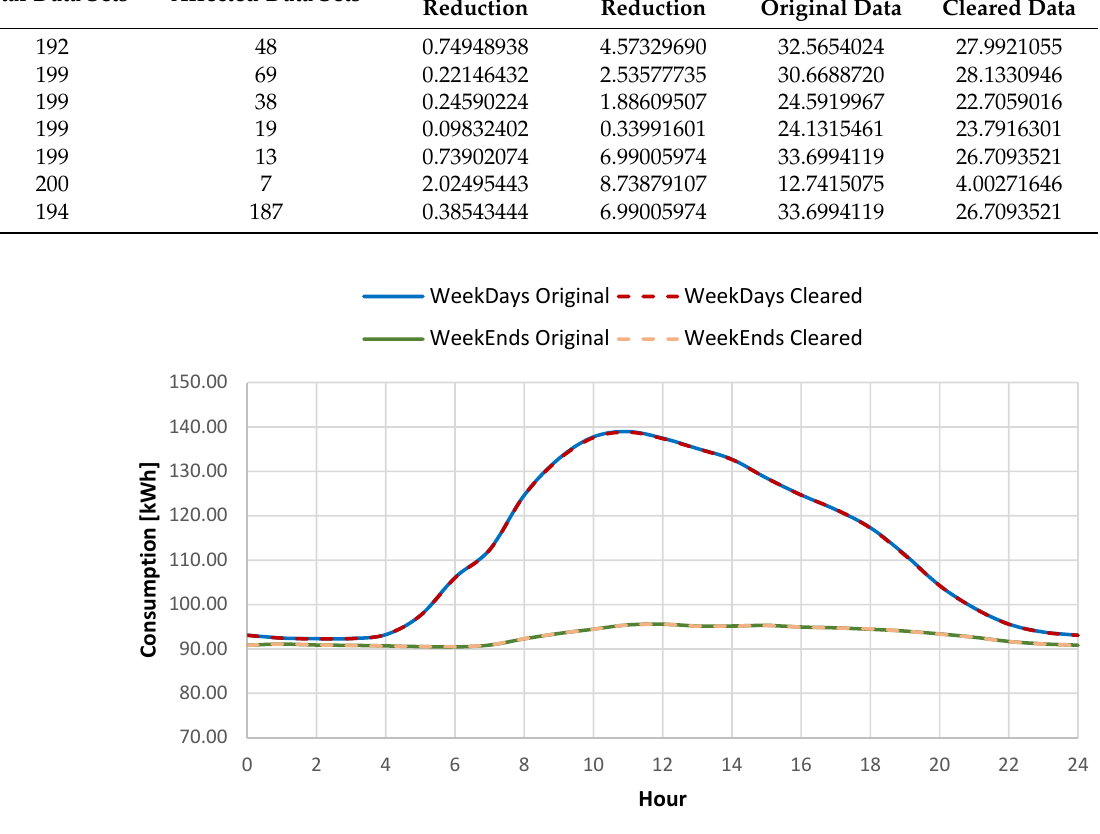
Figure 11. Daily consumption baseline for the original and cleared data sets.